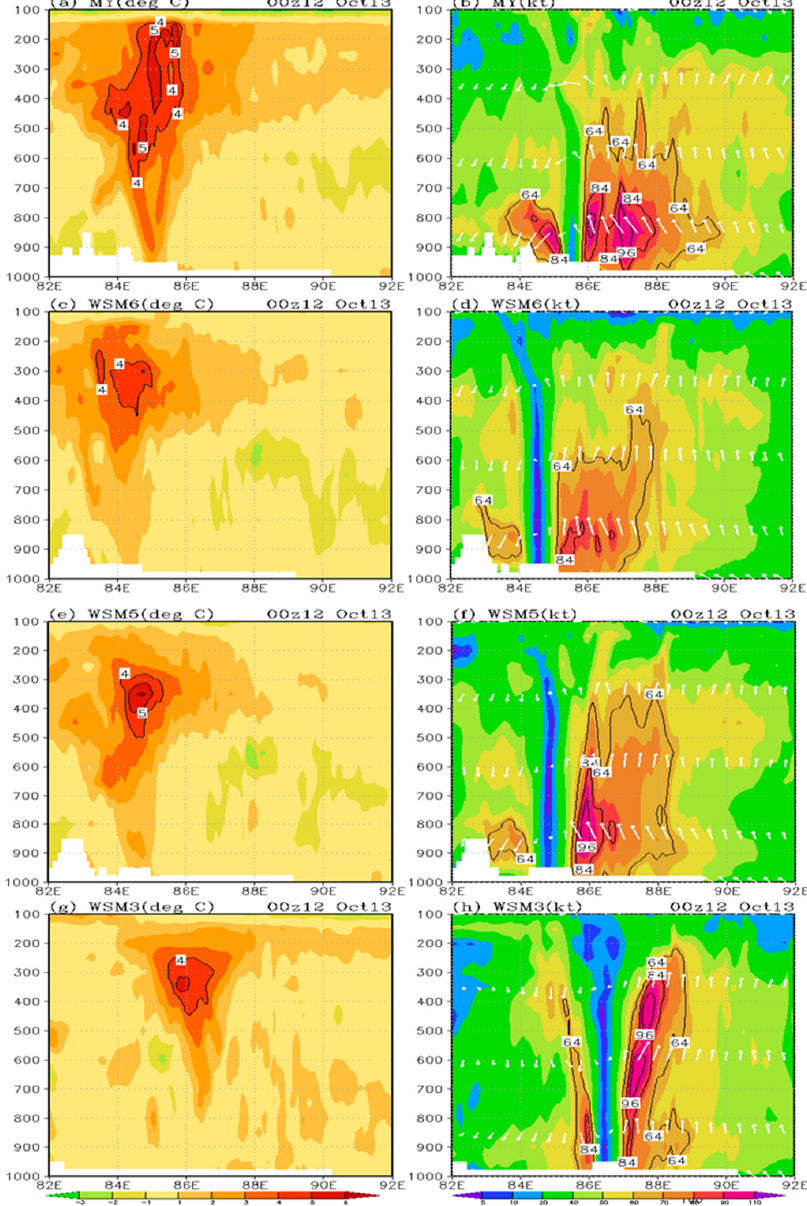
Figure 10. Vertical level and longitudinal cross-sections of ( a ) temperature anomaly (°C) and ( b ) wind field (shaded; ms − 1 ) derived from MY experiment; similarly ( c – d ), ( e-f ) and ( g-h ) were derived from WSM6, WSM5, and WSM3 experiments valid at 00 UTC, 12 October 2013 [as per Saffir–Simpson hurricane wind scale, the wind speed (contour) shown fits category 3, as simulated by WRF experiments].